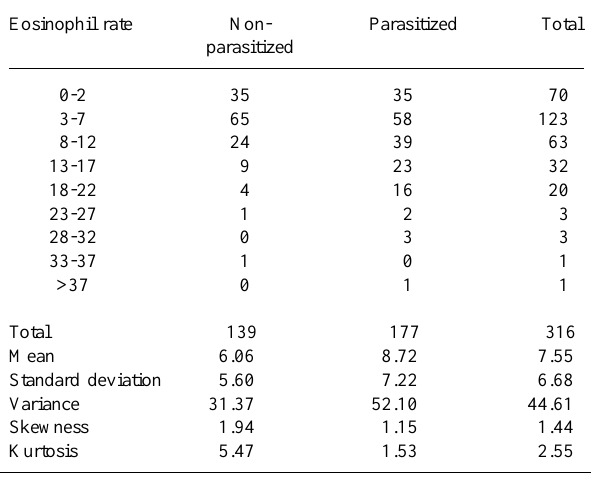
t -value = -3.70, degrees of freedom =